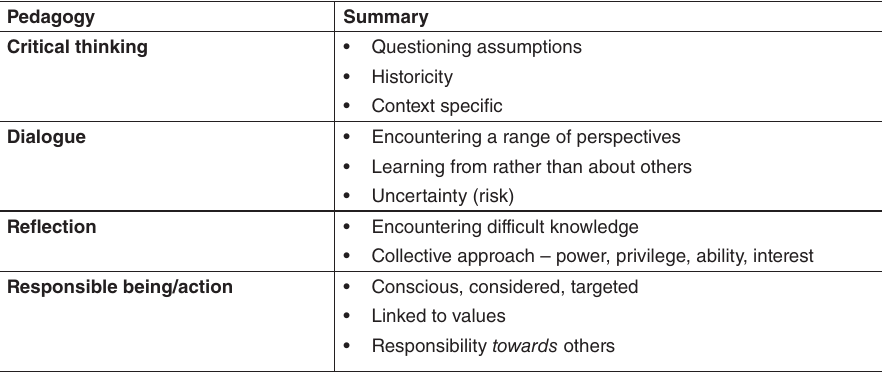
Table 1: A pedagogy of critical global citizenship education Pedagogy